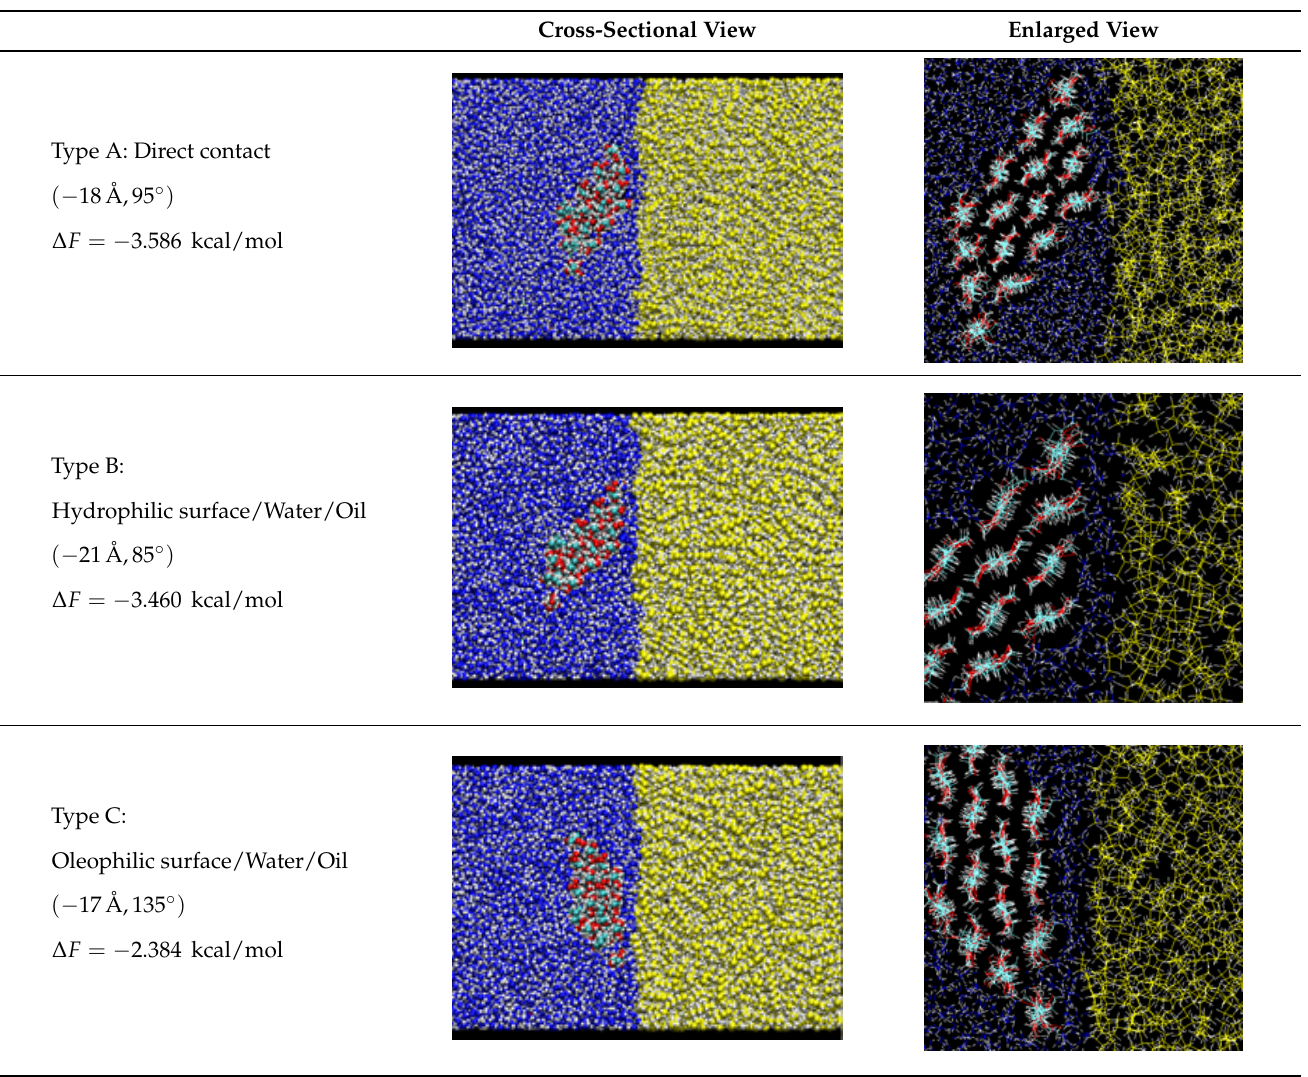
Table 2. Summary of three states of the local minima on the adsorption free energy